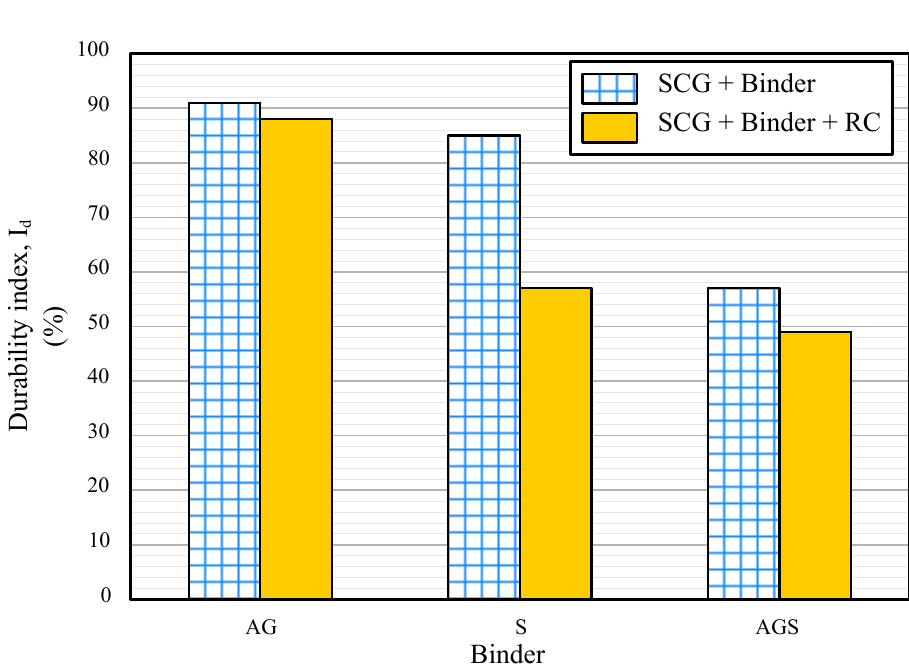
Figure 7. Slake durability index of the samples.